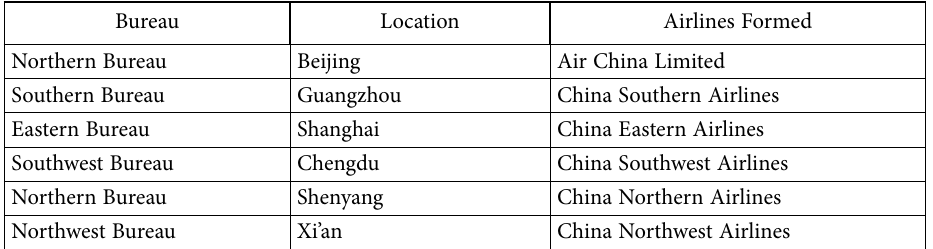
Table 1. Airline companies formed from the six bureaus in the late 1980s Bureau